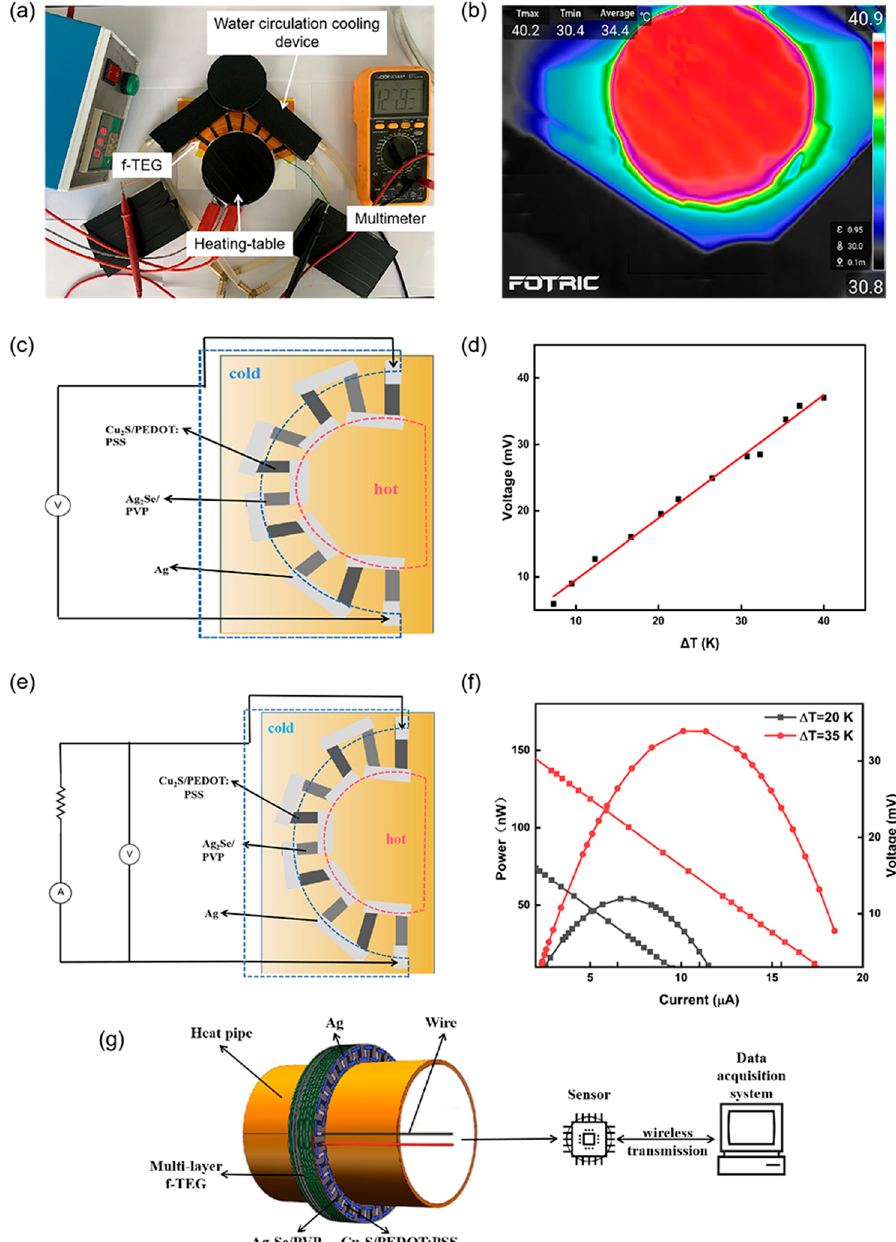
Figure 8. ( a ) Actual test diagram, ( b ) Infrared imager picture, ( c ) Schematic of output voltage test circuit, ( d ) Output voltage variation with temperature, ( e ) Schematic of output power test, ( f ) Schematic of voltage, current, and power relationship when ∆ T is 20 K and 35 K, ( g ) Self-powered underground pipe network by f-TEG.